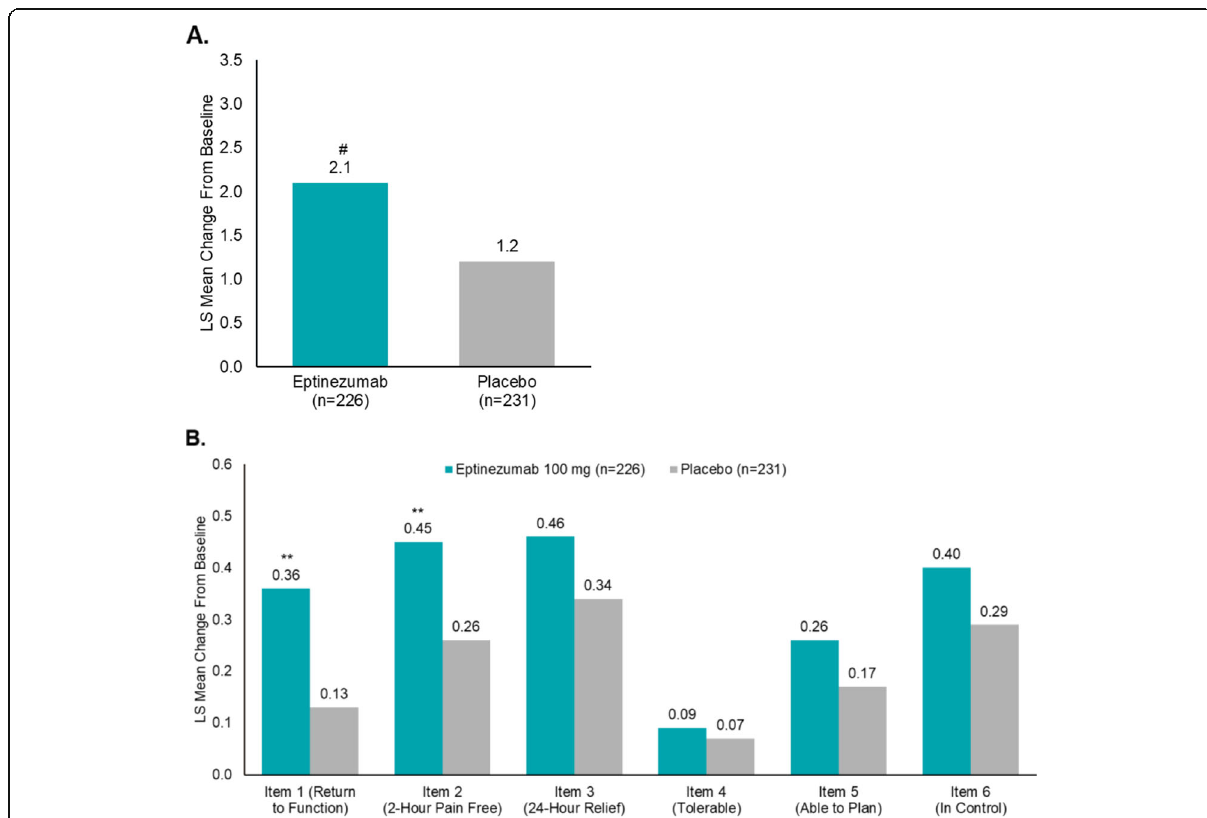
Fig. 3 mTOQ-6 Mean Change From Baseline to Week 4. A Mean change from baseline to week 4 in mTOQ-6 total score and B in mTOQ-6 item scores. mTOQ-6, 6-item Migraine Treatment Optimization Questionnaire. a Limited to patients with both baseline and post-baseline mTOQ-6 data. ** P < .01, # P = .0053 vs